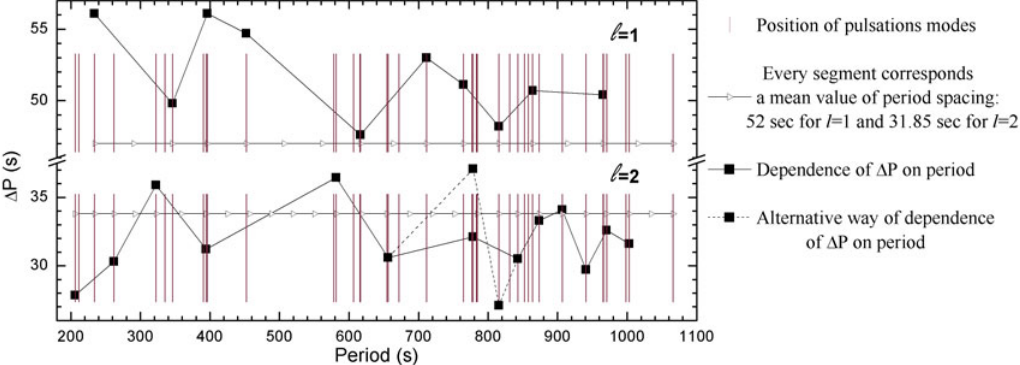
Figure 1. Diagram of “forward” period spacing for PG 2303+243.